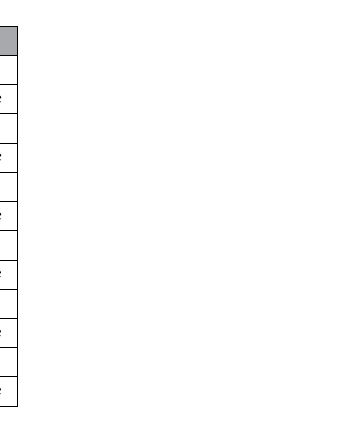
Table 3. Parameters of Freundlich isotherm on 2,4,6-TCP adsorption.